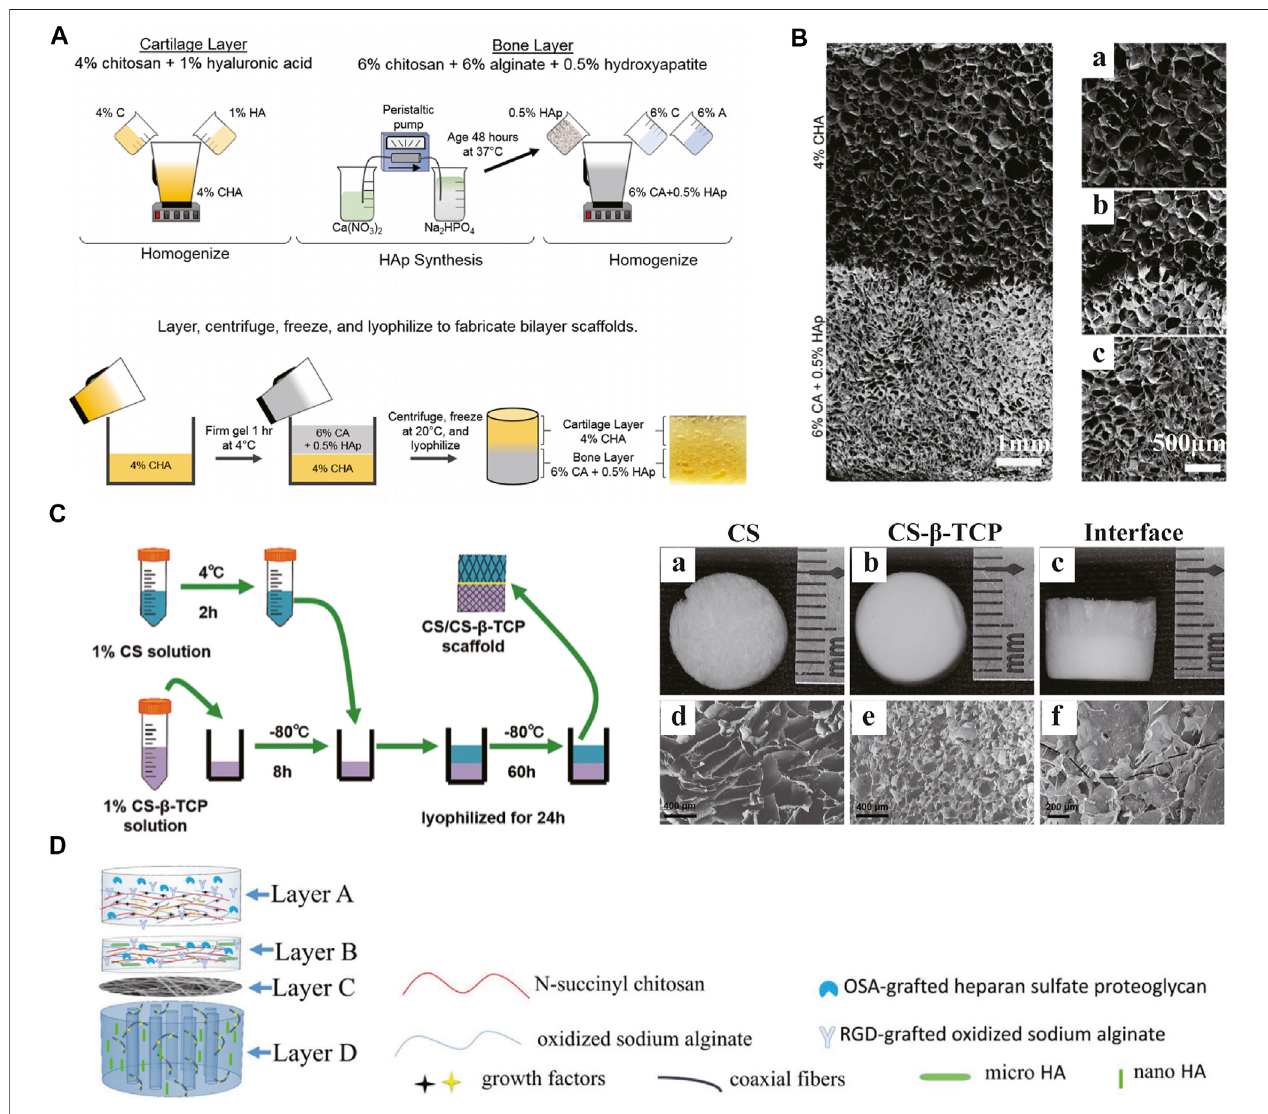
FIGURE7| Compositescaffolds.Thefabricationprocess (A) andSEMimages (B) ofabilayeredcompositescaffoldconsistingof4%CHAcartilagelayer (B:a) and 6% CA + 0.5%HAp bone layer (B: c) with an integrated interface (B: b) . A bilayered CS/CS- β -TCP scaffold (C) was prepared and observed by gross appearance (C: a – c) and SEM (C: d – f) . A composite scaffold with four functional layers improved the integration of implants with host tissues (D) . (A and B) Adapted with permission from ref (Erickson et al.,2019).Copyright2019 bySpringer Science +Business Media LLC. (C) Adapted with permission from ref(Xuet al., 2021).Copyright 2021 by Mary Ann Liebert Inc. (D) Adapted with permission from ref (Chen et al., 2018). Copyright 2018 by Elsevier B.V.